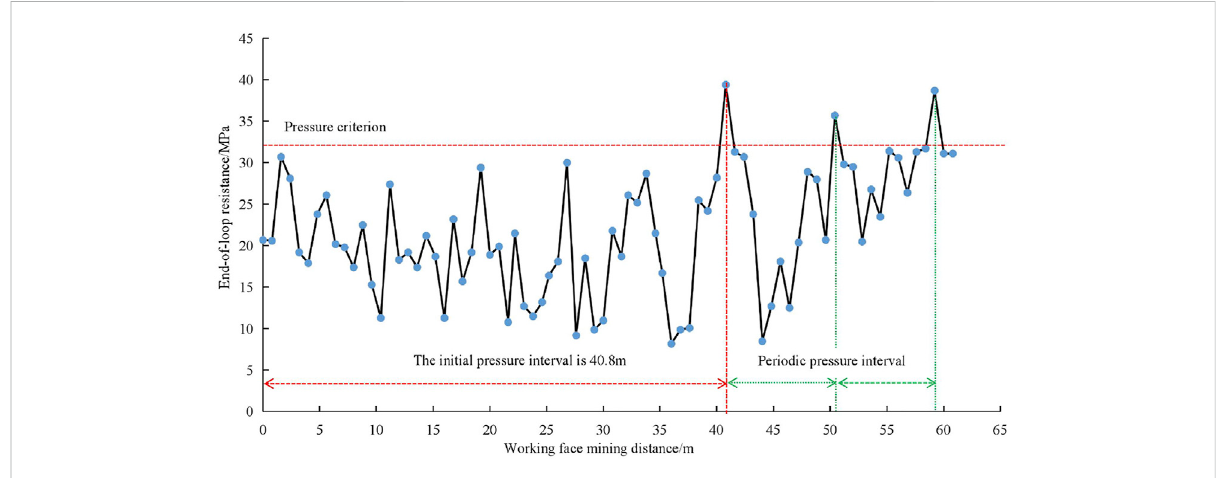
FIGURE 10 Curve of the end-of-loop resistance of the No. 65 hydraulic support.